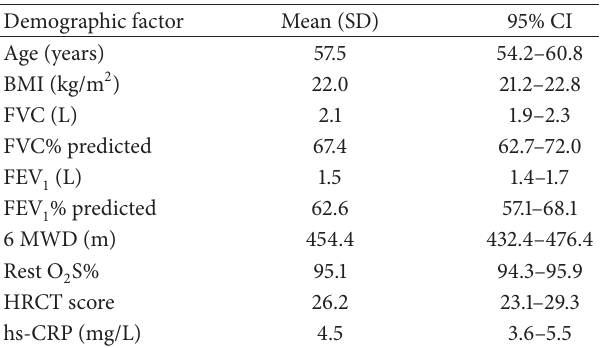
Table 1: Demographic data of the 69 stable bronchiectasis